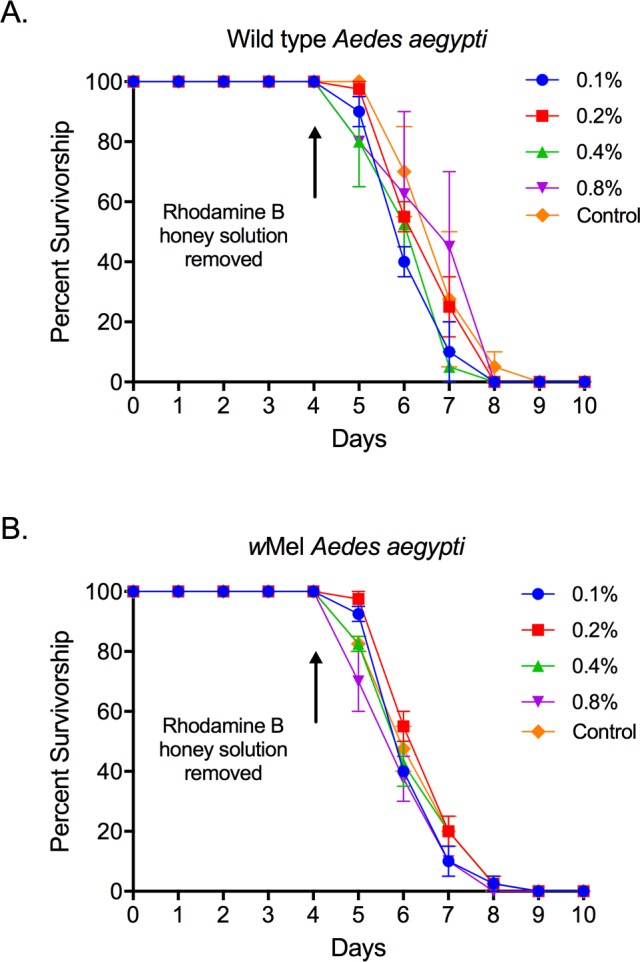
Male survivorship during and after rhodamine B feeding.Percent survivorship (mean±SE) of (A) wild type and (B) wMel Ae. aegypti males during and after 4 d of feeding on 0.1, 0.2, 0.4, and 0.8% (w/v in 50% honey solution) rhodamine B solutions relative to unmarked controls (fed 50% honey).